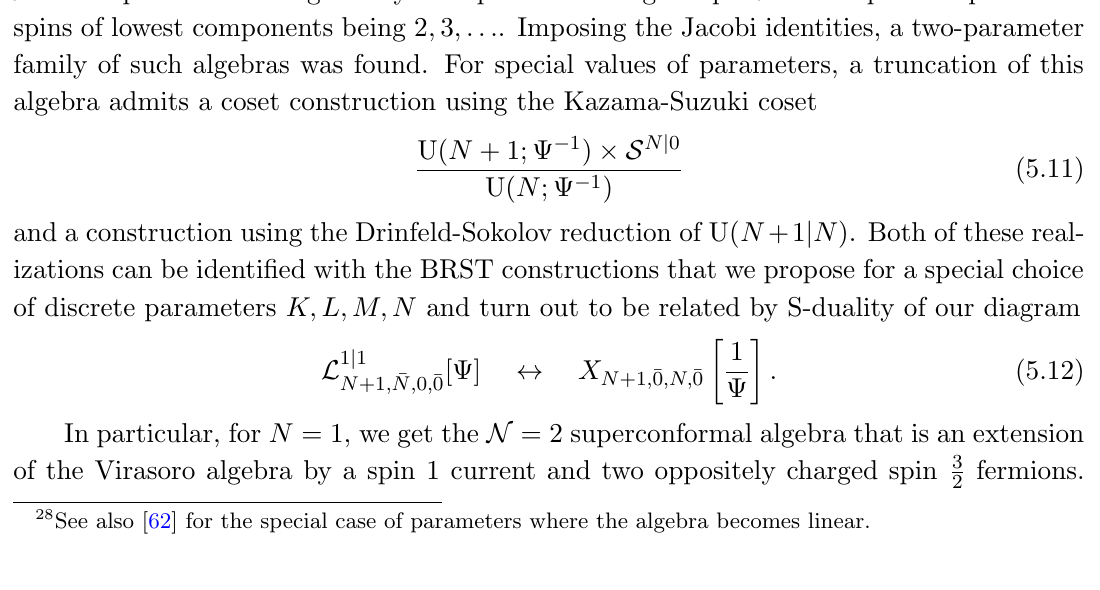
Figure 15. First few truncation curves in the ( (cid:22) 1 ; (cid:22) 3 ) parametrization for 0 (cid:20) (cid:26) (cid:20) 5 number of branes K + L + M + N (cid:20) 8. Note that the (cid:12)gures are invariant under the re(cid:13)ection (cid:22) 1 $ (cid:22) 2 corresponding to the S-duality